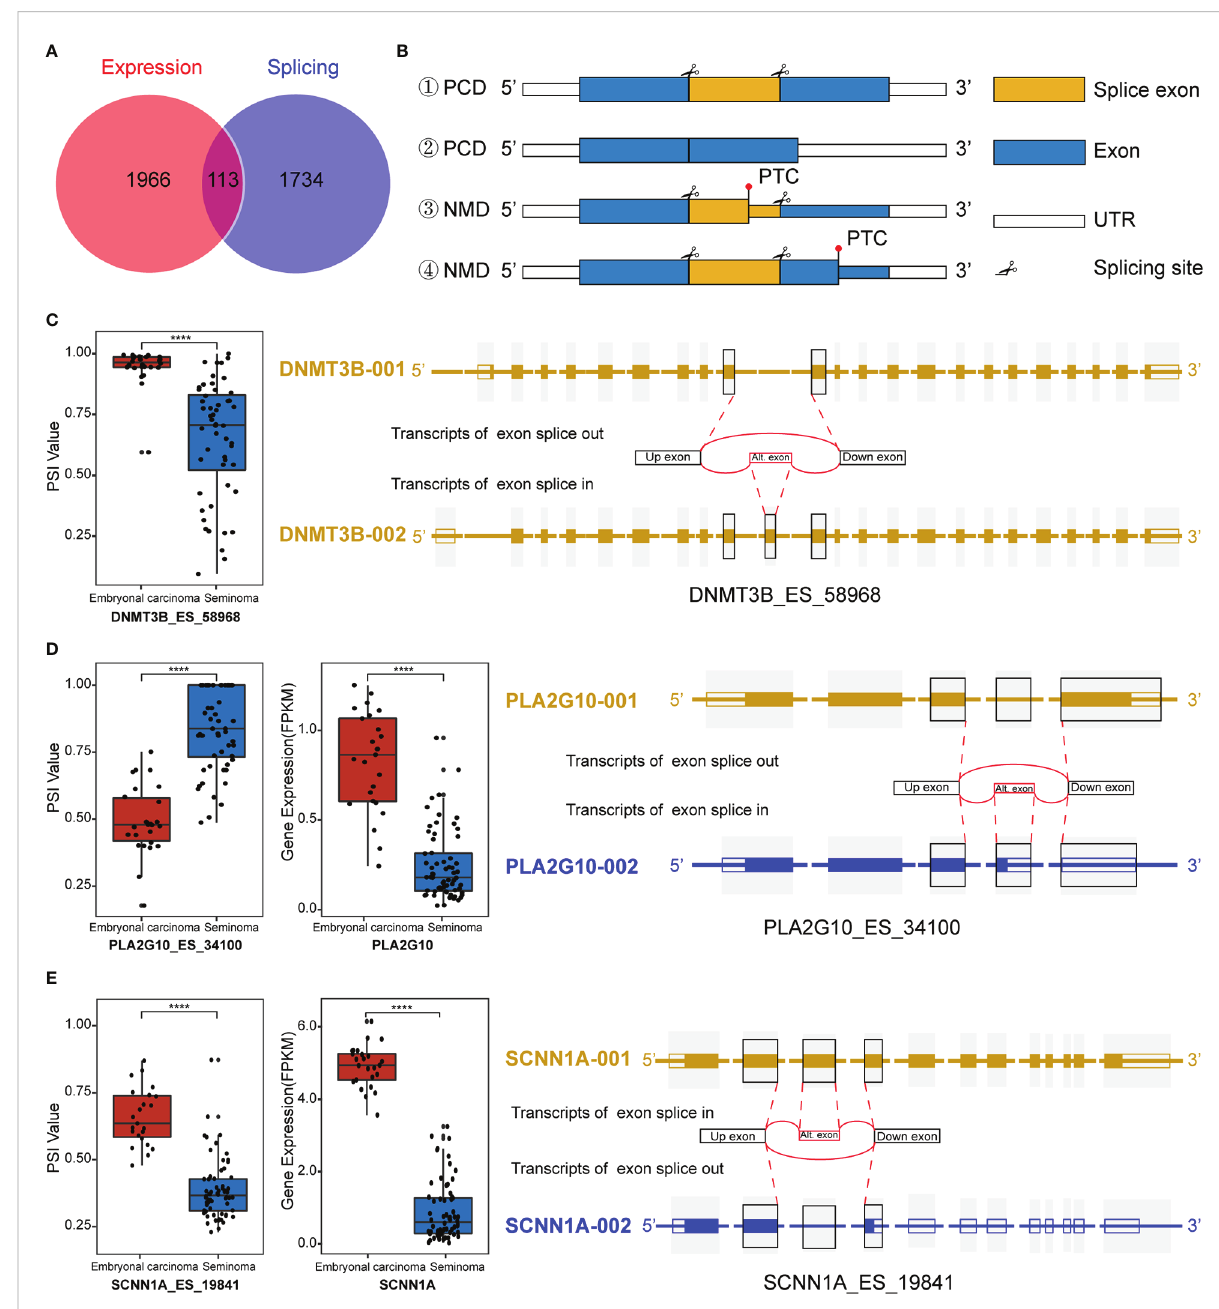
FIGURE 3 Regulation of transcripts by alternative splicing (AS). (A) Venn diagram of differentially spliced (DAS) and differentially expressed genes (DEGs). (B) Maps of transcript length regulated by alternative splicing which happened at different sites. #1 and #2 are long and short isoforms encoding proteins after exon splicing, while #3 and #4 are NMD with premature termination of transcription. PCD: Protein coding. NMD: Nonsense- mediated mRNA decay. PTC: Premature termination codon. UTR: Untranslated regions. (C) Splicing map of the splicing-expression gene DNMT3B. (D, E) Differentially expressed and spliced pro fi le of PA2AG10 and SCNN1A in the two subtypes of TGCT, and the transcriptional maps obtained from the Ensemble website. **** P <